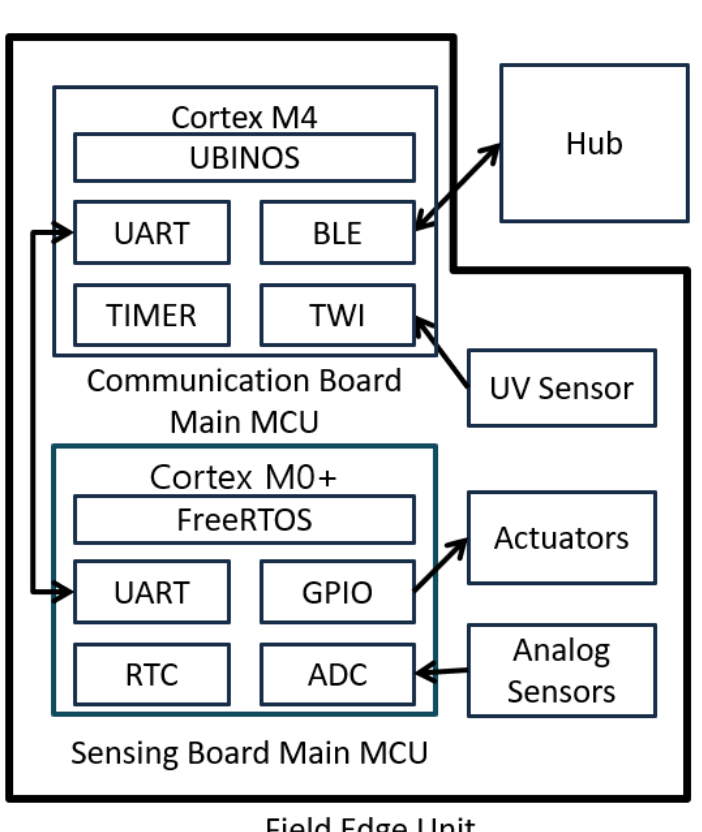
Figure 7. Hardware block diagram of Field Edge Unit.